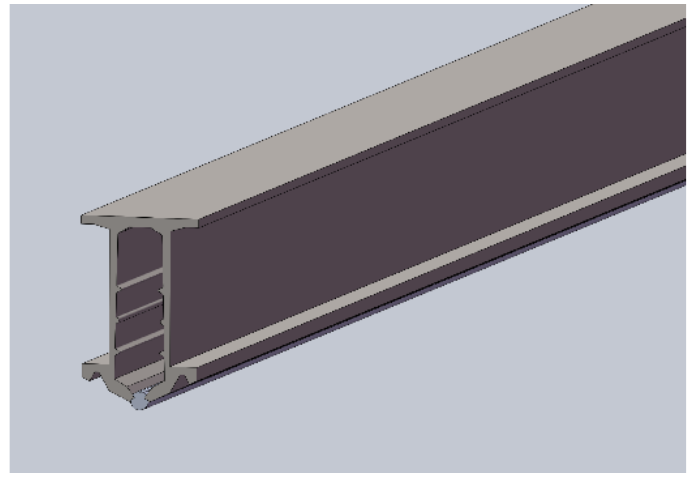
Figure 3. Conductor rail and contact wire model in Solidworks.